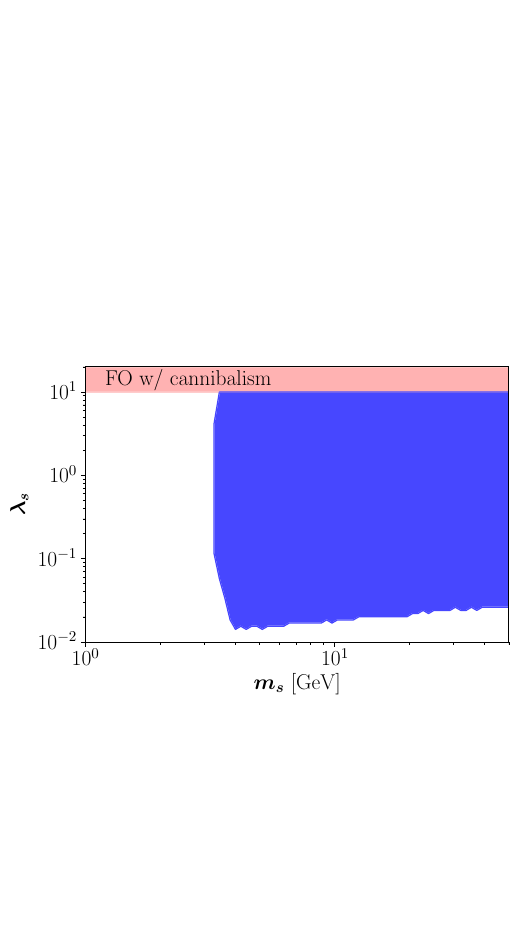
decayed into SM particles must be larger than the BBN temperature and small enough not to not re-trigger DM production, Eq. (6); the DM freeze-out occurs while the s particles are non-relativistic, x FO > 3; in a MD Universe H EW / m h > 1 . 76 × 10 − 16 ; the portal coupling has to satisfy λ hs < 2 m 2 s /v 2 and λ hs ≥ λ eq for the freeze-out case and hs < λ eq λ for the freeze-in case, with λ eq given by Eq. (7). The shaded hs hs hs region in the lower panels corresponds to the reannihilation regime. The black dotted line shows the parameters yielding the correct DM abundance in the usual RD